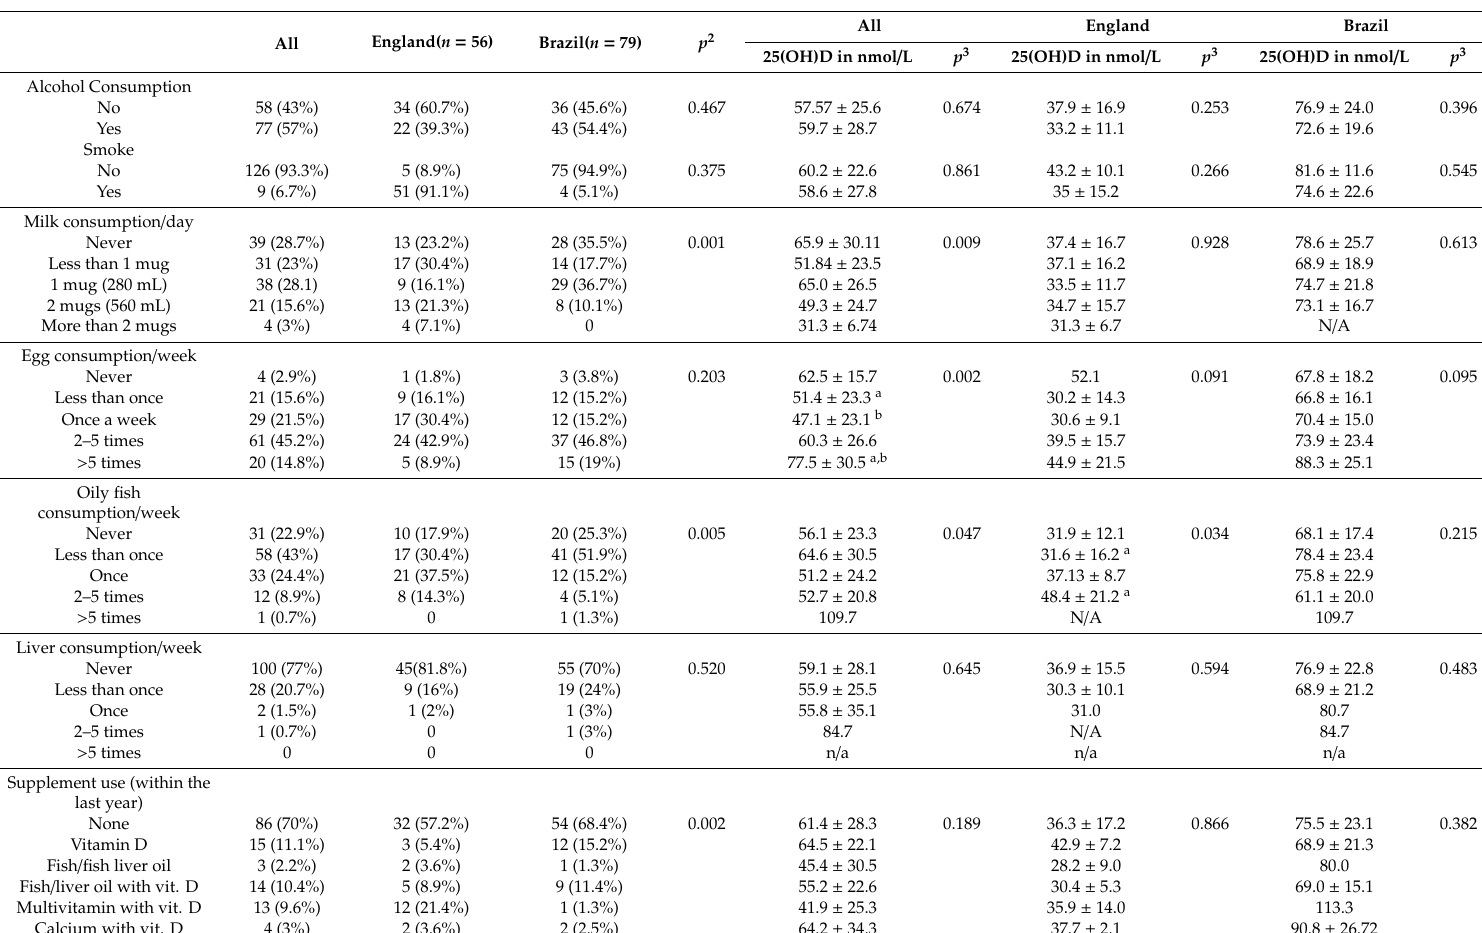
Table 2. Lifestyle characteristics of adult Brazilian women overall and by country of residence ( n = 135) 1